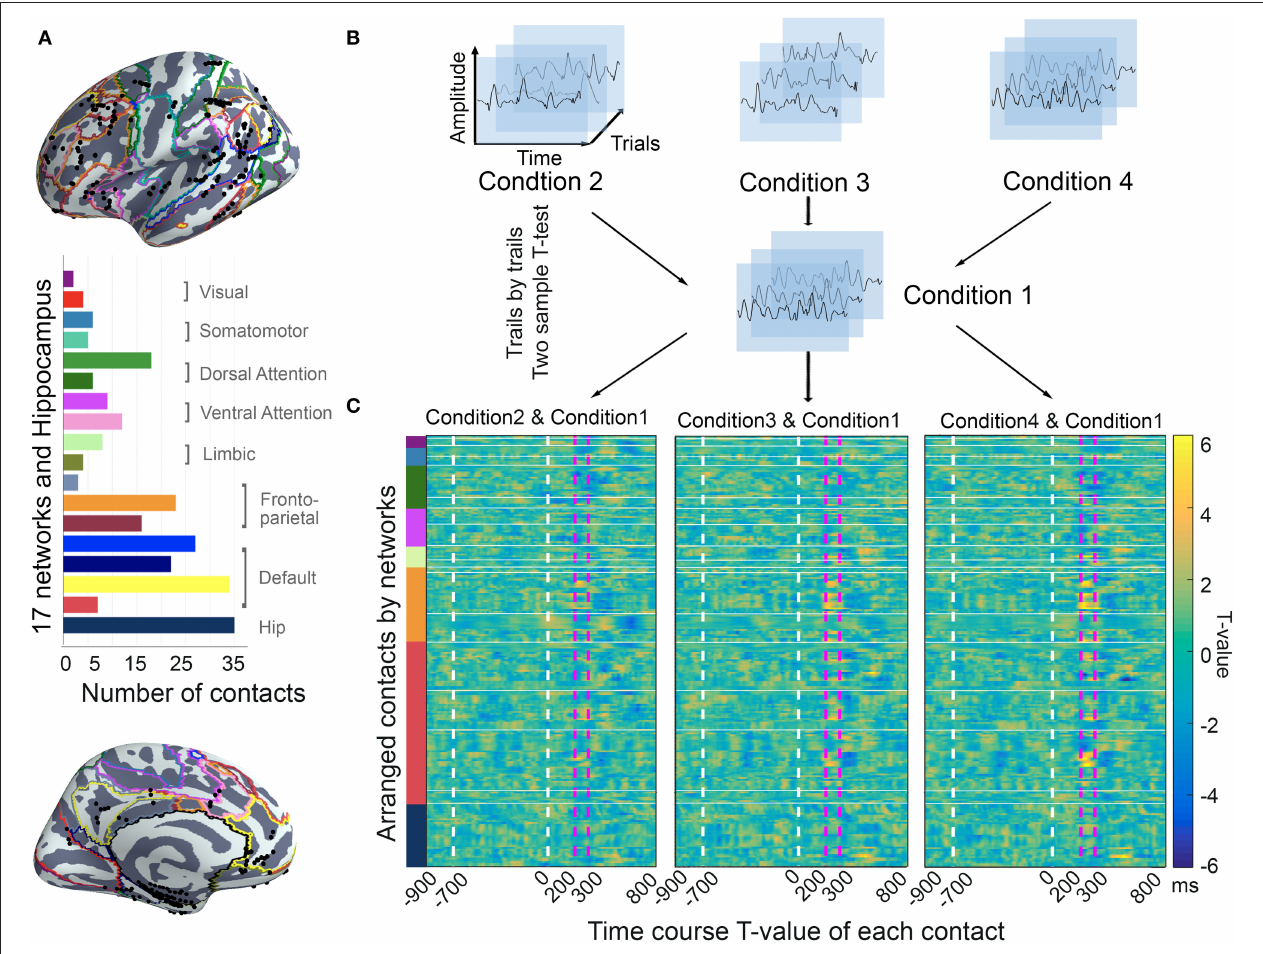
FIGURE 3 | The location of contacts and time course T -value of each contact. (A) Location of contacts. Contacts (10 patients; N = 241) were located on the brain surface with 17 functional network parcellations in standardized MNI space. All the contacts were arrayed in 17-network and hippocampus. The bar plot shows the number of contacts within each brain region. (B) The ERP processing procedure. All the trials were assigned with stimulation time in each condition. The two-sample t -test was used to compare the time course task-evoked changes trail-by-trail. (C) The statistical test results for all contacts, which were arranged in the order of functional networks. The dashed white vertical lines in the plot show the S1 and S2 onsets, and the dashed pink vertical lines mark the time window of interest (200–300ms after S2